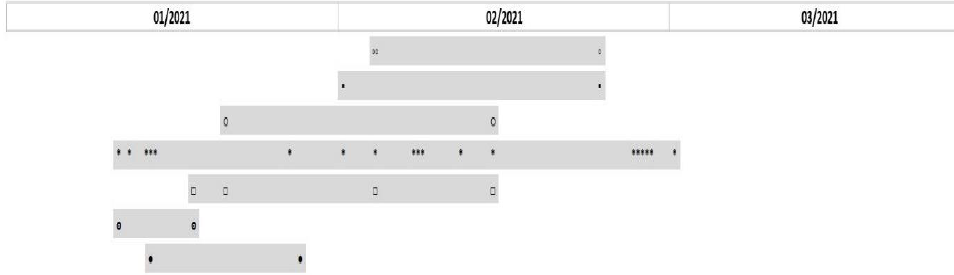
Figure 3. Timeline of the prevalence of Klebsiella pneumoniae clones throughout 3 months of the study duration. The grey rectangles represent 7 clonal groups of Klebsiella pneumoniae based on their similarity. Isolates are represented by signs ◦▪ ○ * □ ꙩ ●.